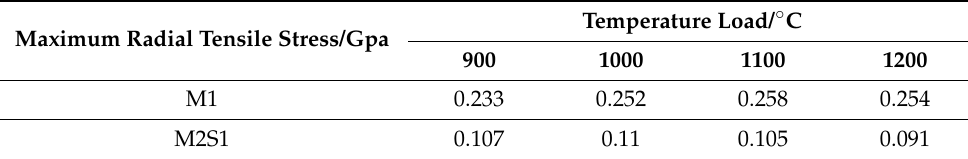
Table 5. Maximum radial thermal stress value of the LMA layer surface of the M1 and M2S1 specimens at the four operating temperatures.